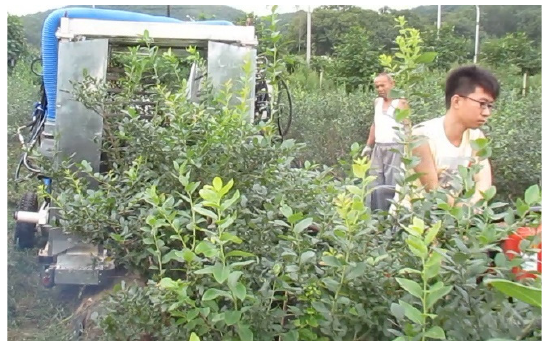
Figure 9. Blueberry harvesting field test.